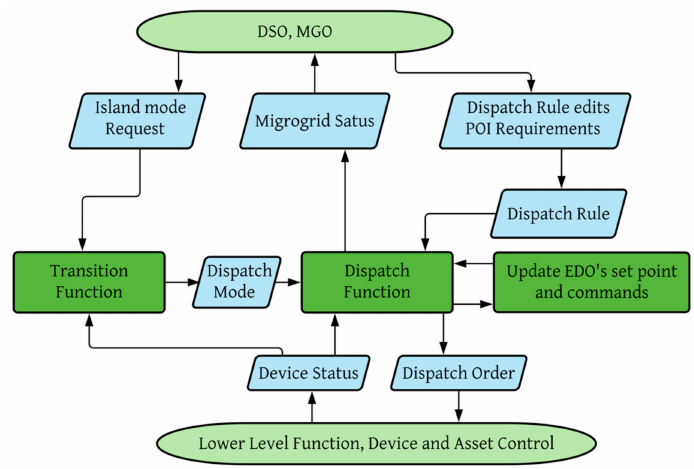
Figure 4. Relationship between transition and dispatch